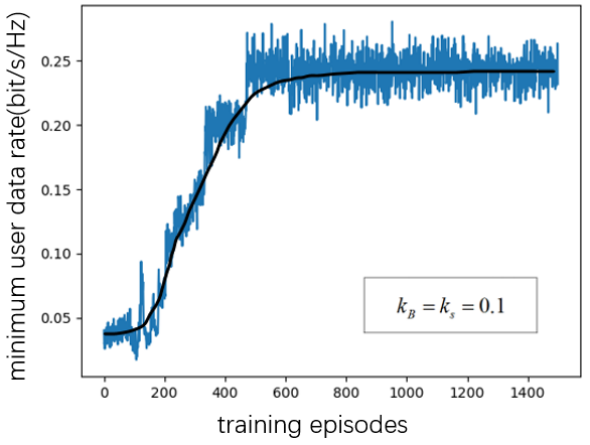
Figure 9. Convergence Speed when k B = k S =